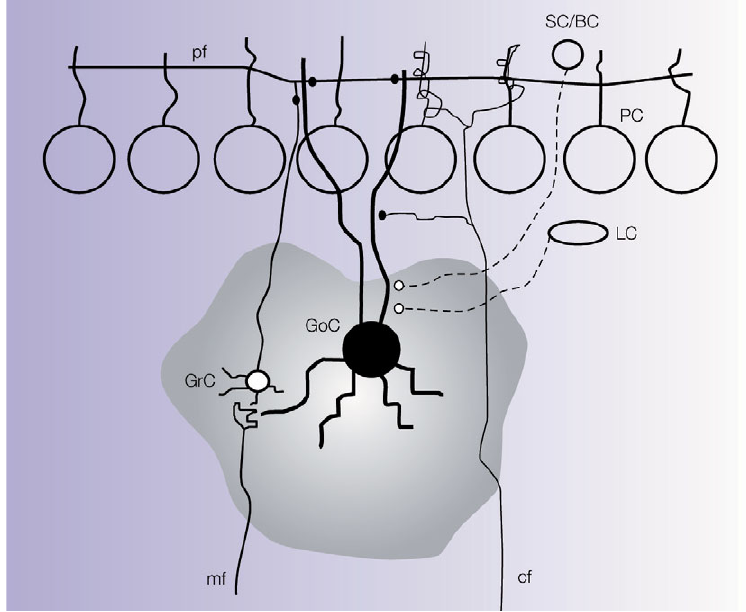
Figure 2 | Connections of the Golgi cell. The picture shows schematically the main connections of the Golgi cell (GoC) from available morphological data (Cajal, 1995; Eccles et al., 1967; Palay and Chan-Palay, 1974). The mossy fi bers (mf) contact the basal GoC dendrites and the granule cell (GrC) axon contacts the apical GoC dendrites through the parallel fi bers (pf). The climbing fi bers (cf) send a collateral to the GoC. The stellate cells (SC), basket cells (BC) and Lugaro Cells (LC) send inhibitory contacts to the GoC. The gray area identifi es the axonal fi eld of the GoC. It should be noted that the glomerular localization of the mf-GrC connection has not been fully documented and that functional evidence for the cf-GoC connection is still